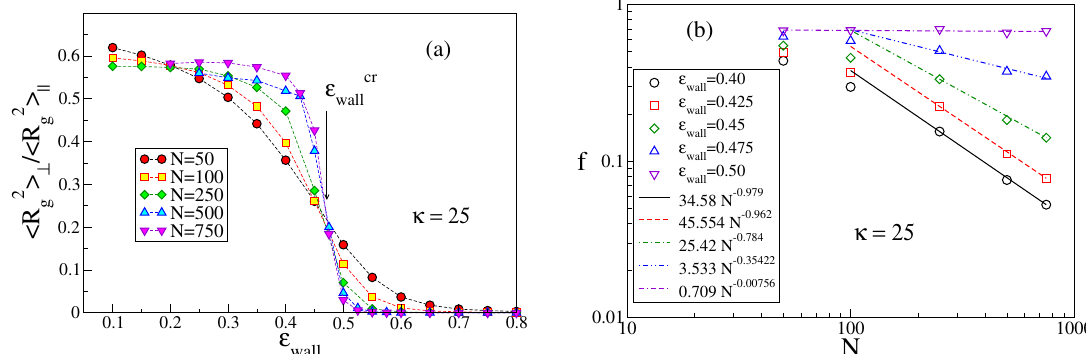
Figure 3. ( a ) Ratio of perpendicular and parallel parts (cid:104) R 2 g (cid:105) ⊥ / (cid:104) R 2 g (cid:105) || of the mean square gyration radius of semiflexible macromolecules with κ = 25, plotted vs. strength (cid:101) wall of the adsorption potential for five choices of N . A second order adsorption transition should show up as universal crossing point of = 0.47 ± 0.01 is indicated by an arrow, ( b ) log-log the curves for large N . The resulting estimate (cid:101) cr wall plot of the adsorbed fraction of monomers f vs. chain length for κ = 25 and five choices of (cid:101) wall , as indicated. Broken straight lines denote power laws, the slopes show the resulting effective